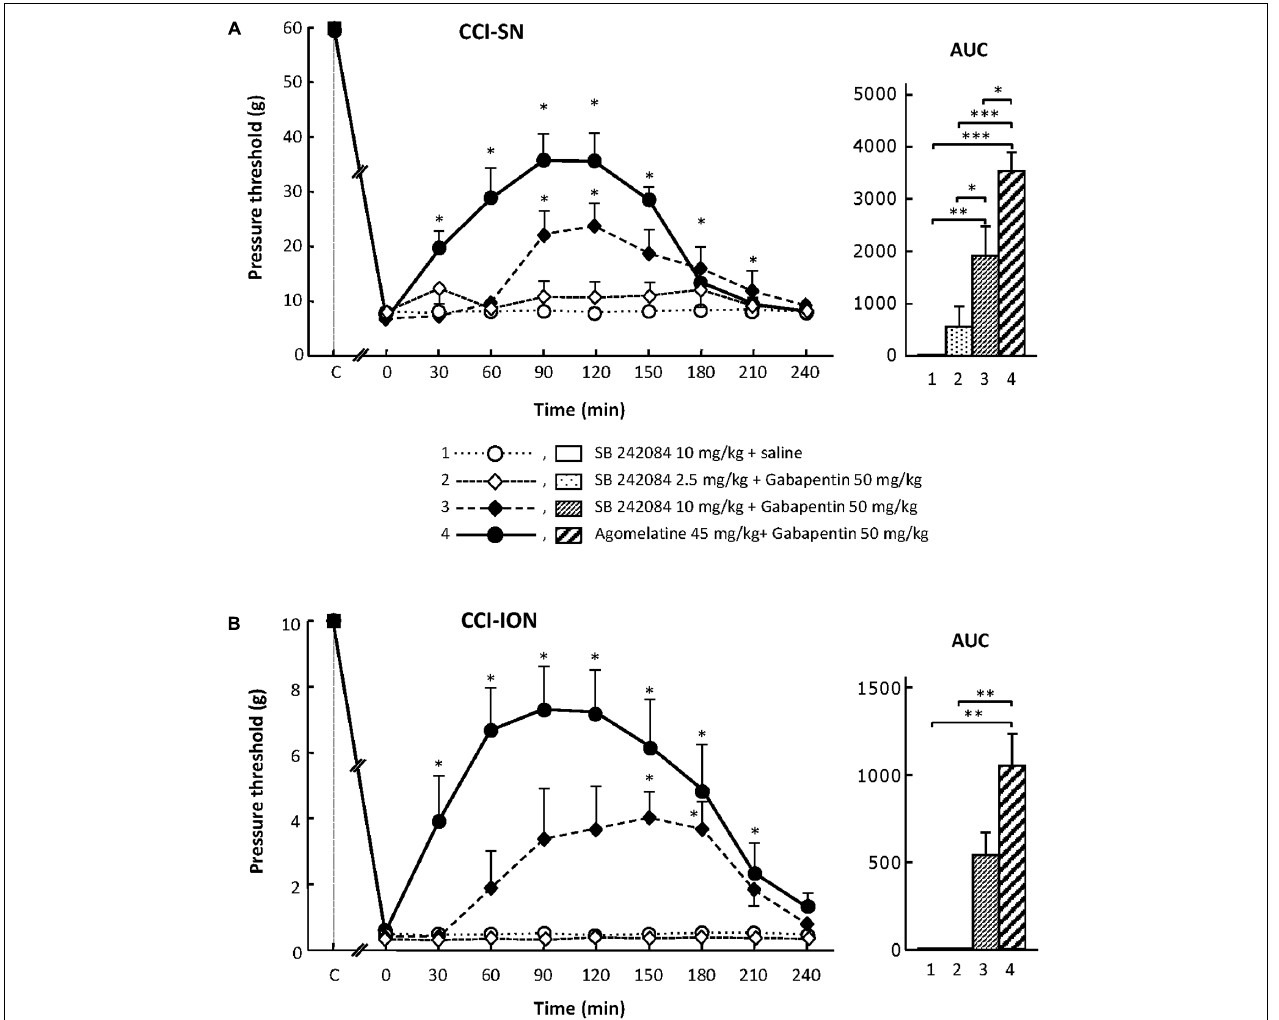
FIGURE 5 | Effects of SB 242084 alone or co-administered with gabapentin on mechanical allodynia in CCI-SN (A) and CCI-ION (B) rats. Comparison with the anti-allodynic effect of ‘agomelatine + gabapentin.’Left panels: SB 242084 (10 mg/kg), SB 242084 (2.5 or 10 mg/kg) + gabapentin (50 mg/kg), agomelatine (45 mg/kg) + gabapentin, and/or respective vehicles (saline, HEC; not shown) were injected i.p. 2 weeks after nerve ligation. Pressure threshold values (as g) were determined as described in the legend to Figure 1 . Each point is the mean ± SEM of n independent determinations. ∗ P < 0.05, compared with pressure threshold values determined just prior to drug injection (0 on abscissa), one way ANOVA with repeated measures, Dunnett’s test. C on abscissa: intact healthy rats before surgery. In both CCI-SN (A) and CCI-ION (B) rats, ‘saline+HEC’-treated groups were also included, but, for the sake of clarity, corresponding data are not represented as they superimposed with those obtained in rats treated with SB 242084 plus saline. Right panels: AUC values calculated from the respective time-course curves: (1) SB 242084 (10 mg/kg) + saline [ n = 7 (A) , n = 5 (B) ]; (2) SB 242084 (2.5 mg/kg) + gabapentin ( n = 8/6); (3) SB 242084 (10 mg/kg) + gabapentin ( n = 10/8); (4) agomelatine + gabapentin ( n = 7/7). A- CCI-SN : one way ANOVA [ F (3,28) = 16.76, P < 0.0001] followed by Tukey’s test ( ∗ P < 0.05, ∗∗ P < 0.01, ∗∗∗ P < 0.001); B- CCI-ION: one way ANOVA [ F (3,22) = 7.98, P = 0.0009] followed by Tukey’s test ( ∗∗ P <